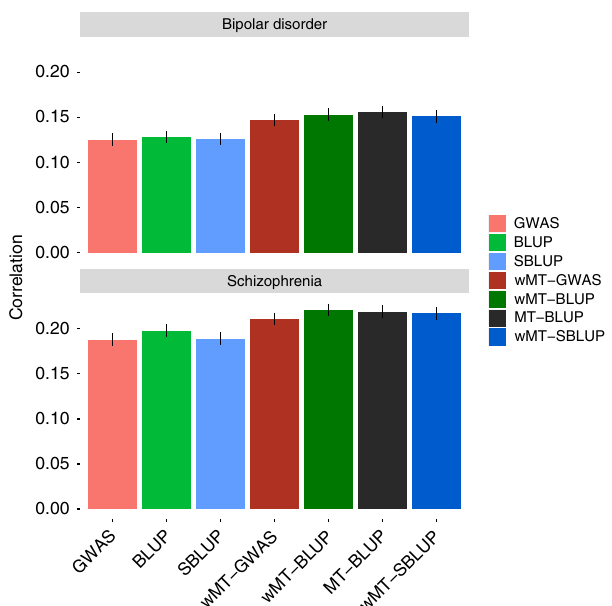
Fig. 3 Prediction accuracy for schizophrenia and bipolar disorder from several single-trait and multi-trait predictors. Prediction accuracy of seven different types of predictors using PGC1 schizophrenia and bipolar disorder data. Single-trait predictor (lighter colours) are on the left, multi-trait predictors (darker colours) are on the right. Black error bars indicate correlation coef fi cient standard errors, calculated as se r